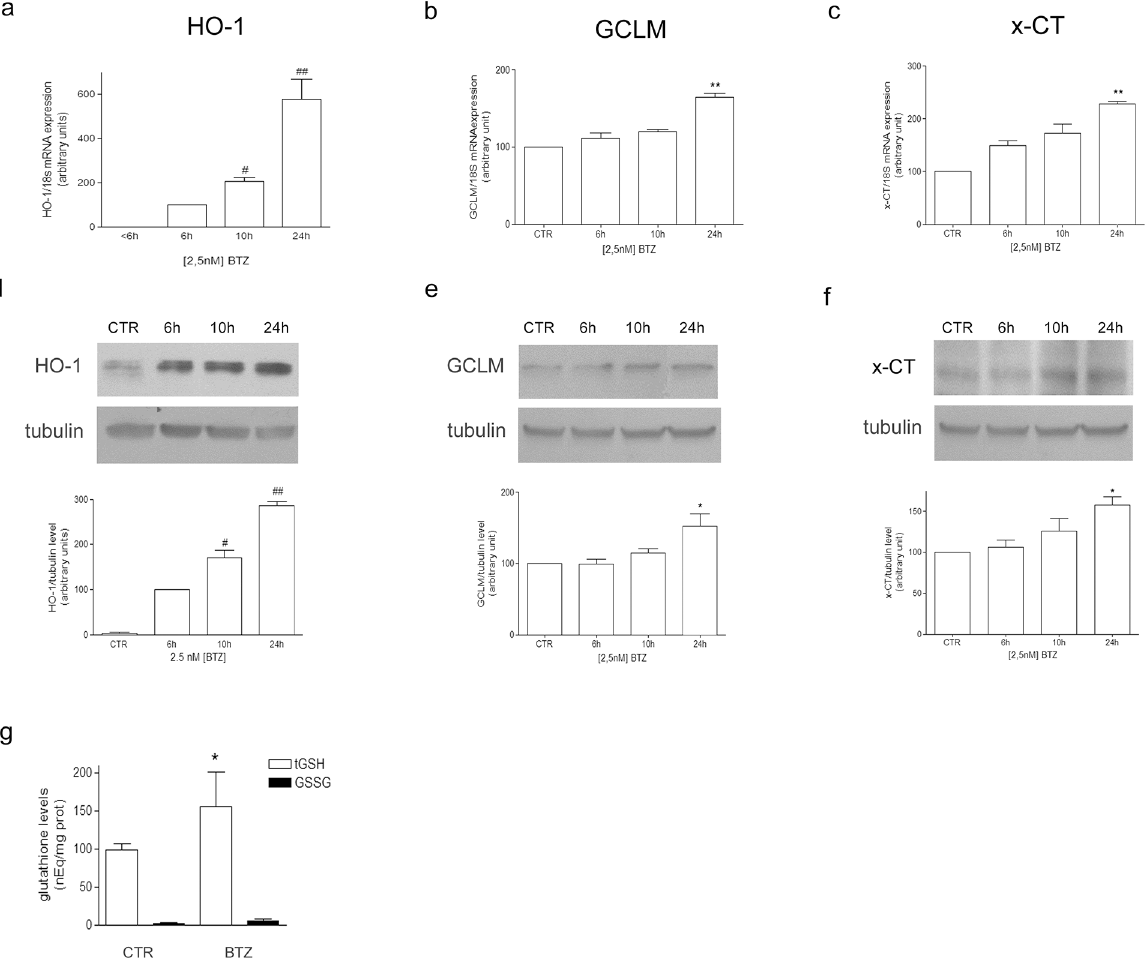
Fig 2. BTZ enhances mRNA expression of HO-1, GCLM and x-CT and increases total GSH level. mRNA and protein level of HO-1 (a and d, respectively), GCLM (b and e, respectively) and x-CT (c and f, respectively) were measured by means of RT-PCR and Western Blotting in cell treated with 2.5 nM BTZ up to 24 h, as detailed in Materials and Methods. PCR products were separated by agarose electrophoresis and the relative intensities of the bands were normalized to 18S expression (a, b, c). The intensities of protein bands were normalized to the level of tubulin (d, e, f). The bar graphs show the mean values of three independent experiments (mean ± SE). The bands show one representative experiment. In (g) tGSH and GSSG content was measured by HPLC in cells treated with 2.5 nM BTZ for 24 h. The graph shows the mean values of three independent experiments (mean ± SE). In (a and d) #p < 0.05 and ##p < 0.01 vs 6 h BTZ-treated cells. In (b, c, d, e and g) * p < 0.05 and ** p < 0.01 vs untreated